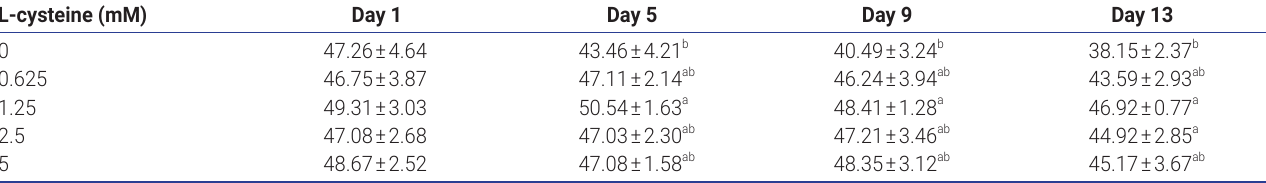
Table 3. Effects of different concentrations of cysteine on sperm straight-line velocity (VSL, μm/s) during the liquid